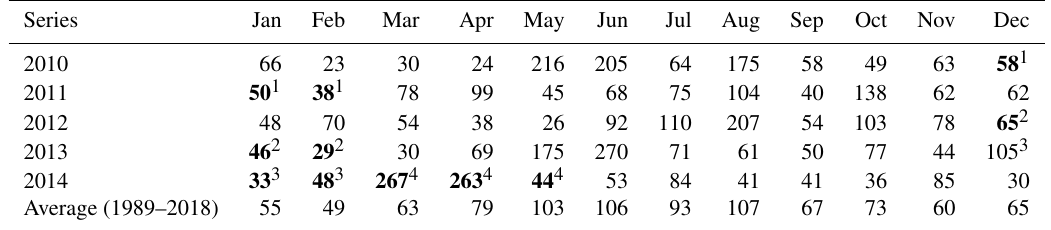
Table 1. Rainfall data (mm) recorded at the Governors Bay weather station between 2010 and 2014, with the weather station average over 20 years provided for comparison. Bold indicates months of interest in this